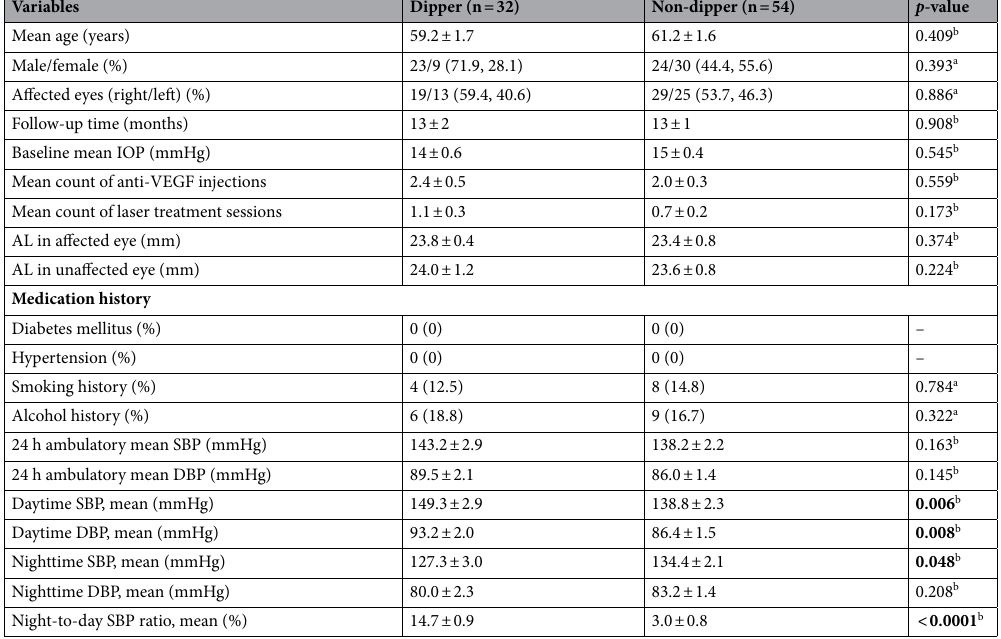
Table 1. Clinical characteristics of the dipper and non-dipper groups of patients diagnosed with branch retinal vein occlusion according to the dipping pattern of the nocturnal systolic blood pressure. Data are presented as mean ± standard deviation or number (%). Night to day systolic blood pressure ratio (%) = (Daytime sysBP − Nighttime sysBP)/Daytime sysBP × 100. Dipper ≥ 10%; Non-dipper < 10%. Statistically significant values appear in boldface. IOP intraocular pressure, VEGF vascular endothelial growth factor, AL axial length. a Based on Pearson’s chi-square test for categorical variables. b Based on Student’s t-test for continuous